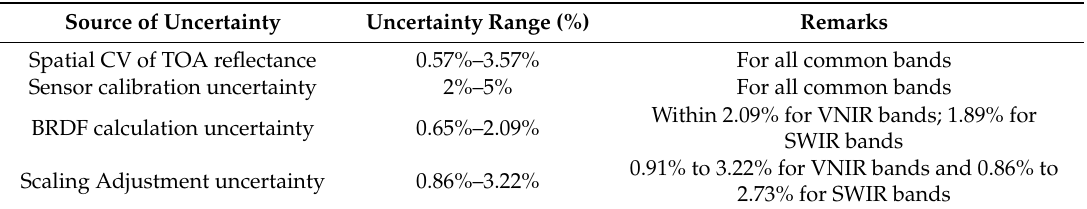
Table 14. Estimated range of average homogenized TOA reflectance uncertainty for 4 di ff erent sources across 6